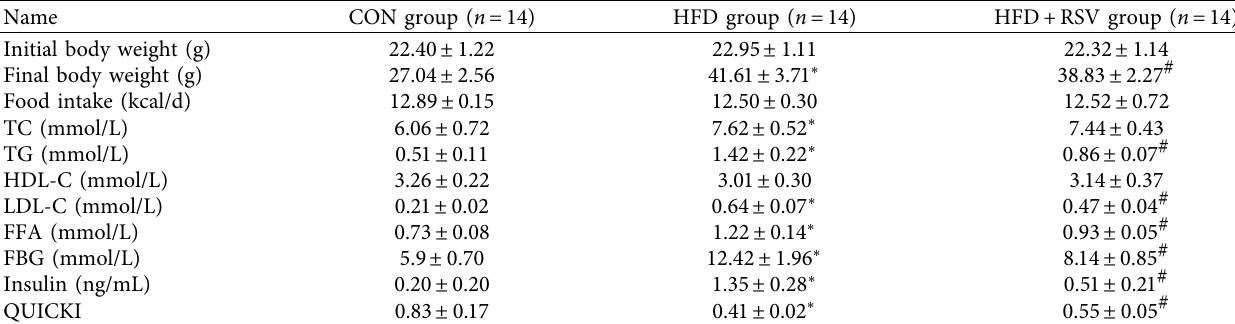
Table 2: General indicators after resveratrol treatment.